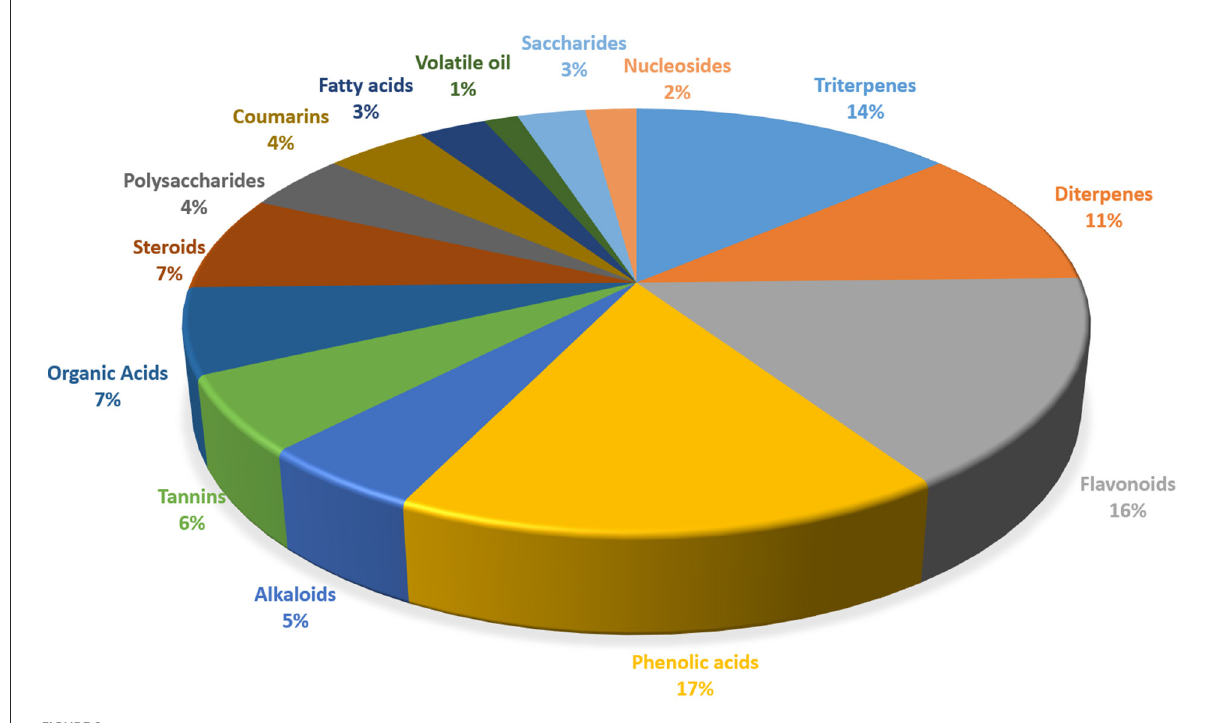
FIGURE2 The portion of different components of R. chingii